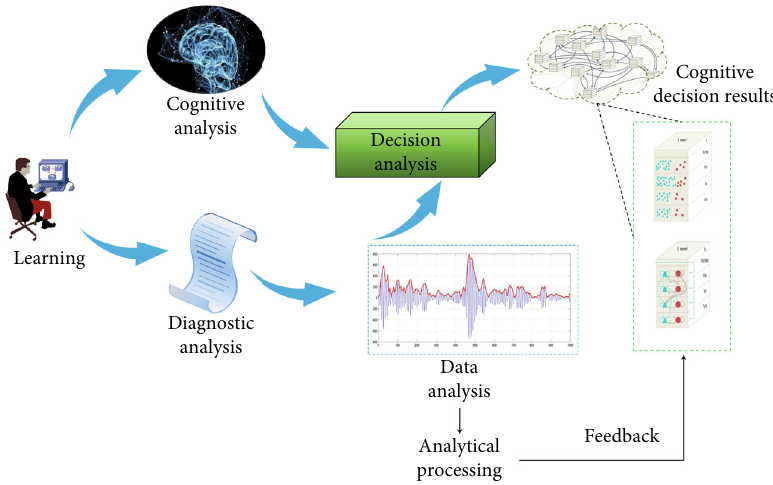
Figure 2: Process analysis of cognitive